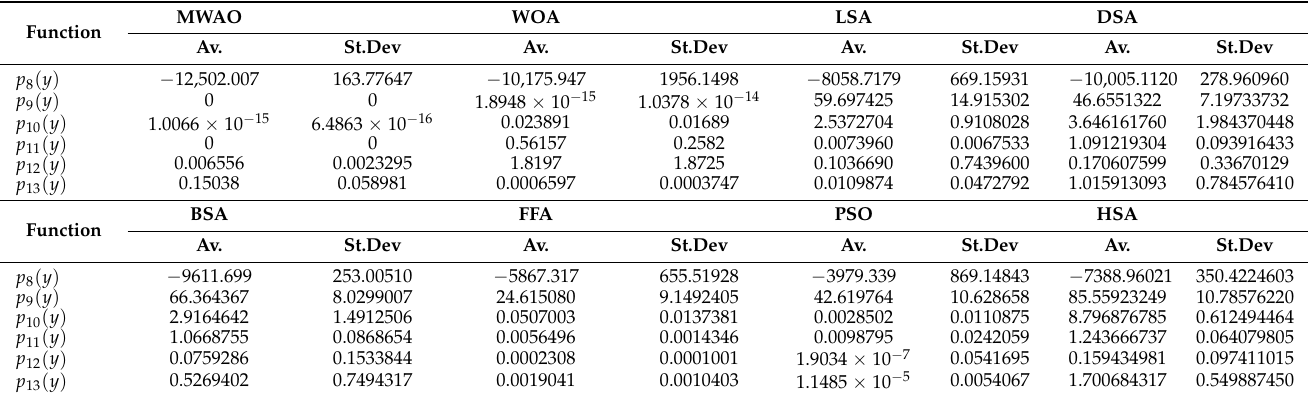
Table 4. Statistical result of different algorithms derived on multimodal 30-dimensional benchmark functions for 50